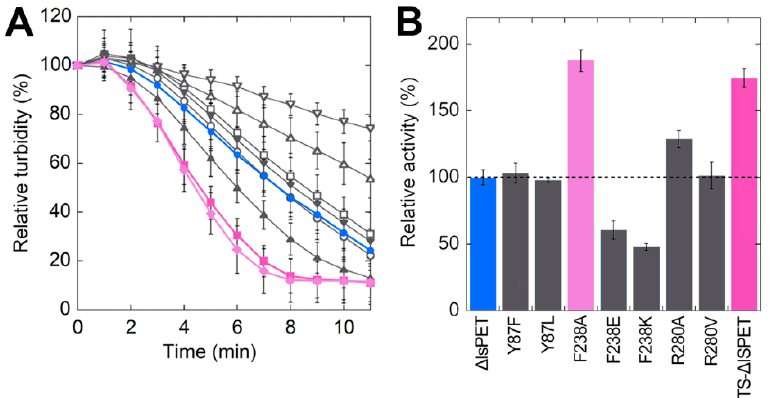
Figure 3. Hydrolytic activity of ∆ IsPET variants on PET nanoparticles. ( A ) Decrease in turbidity of the reaction mixture as a function of time. ( B ) Relative activity of variants on PET nanoparticles (the activity of the wild-type enzyme is set as 100%). Reaction conditions: 50 mM sodium phosphate buffer, 100 mM NaCl, pH 8.0, at 30 °C with 0.094 mg mL − 1 of nanoparticles and 0.04 mg mL − 1 Δ IsPET variants. Δ IsPET ( ● , blue), Y87F ( ○ ), Y87L ( □ ), F238A ( ♦ , pink), F238E ( △ ), F238K ( ▽ ), R280A ( ▲ ), R280V ( ▼ ), and TS ( ■ , violet) variants. Error bars indicate the standard deviation ( n = 3).